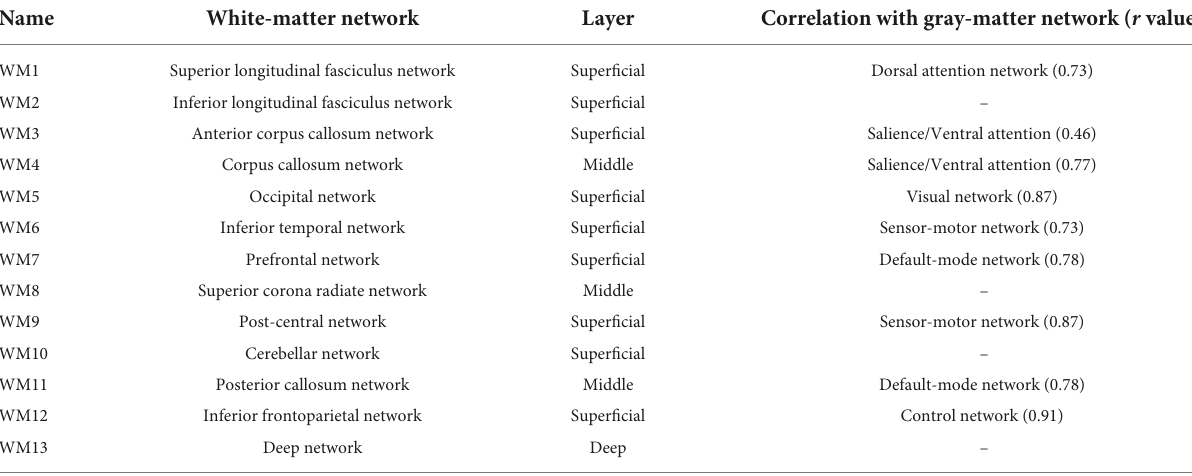
TABLE 2 White-matter functional